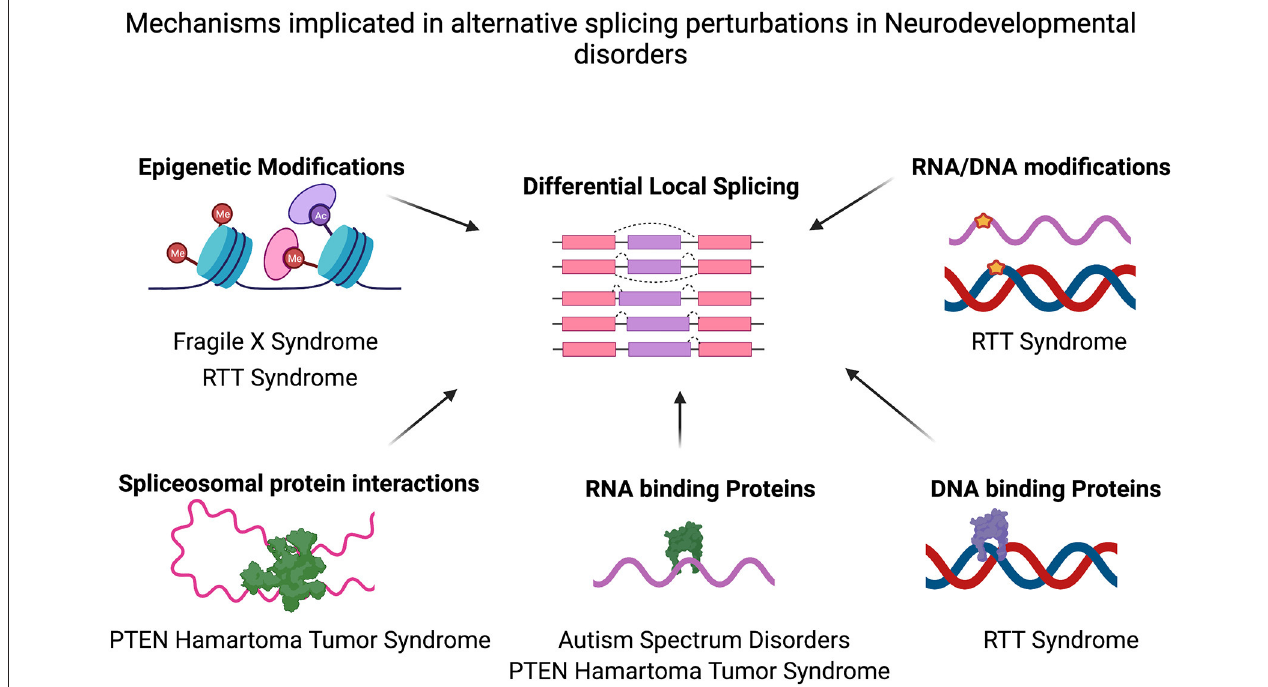
FIGURE 1 | Mechanisms implicated in alternative splicing perturbations in various neurodevelopmental disorders. Differential alternative splicing results in various transcript isoforms generated from a single gene via splicing events (for example, Exon Skipping, Mutually exclusive exon usage, Alternative 3 ′ Splice site/5 ′ splice site usage or intron retention). Various molecular mechanisms may cause the genome-wide alternative splicing perturbations identified in several neurodevelopmental disorders such as epigenetic modifications (e.g., in FXS, RTT Syndrome) and/or splicing factor alterations (e.g., PTEN, autism) or as a result of DNA modifications and differential binding of proteins to DNA (RTT Syndrome). Figure created with Biorender.com. Also see Table 1 .